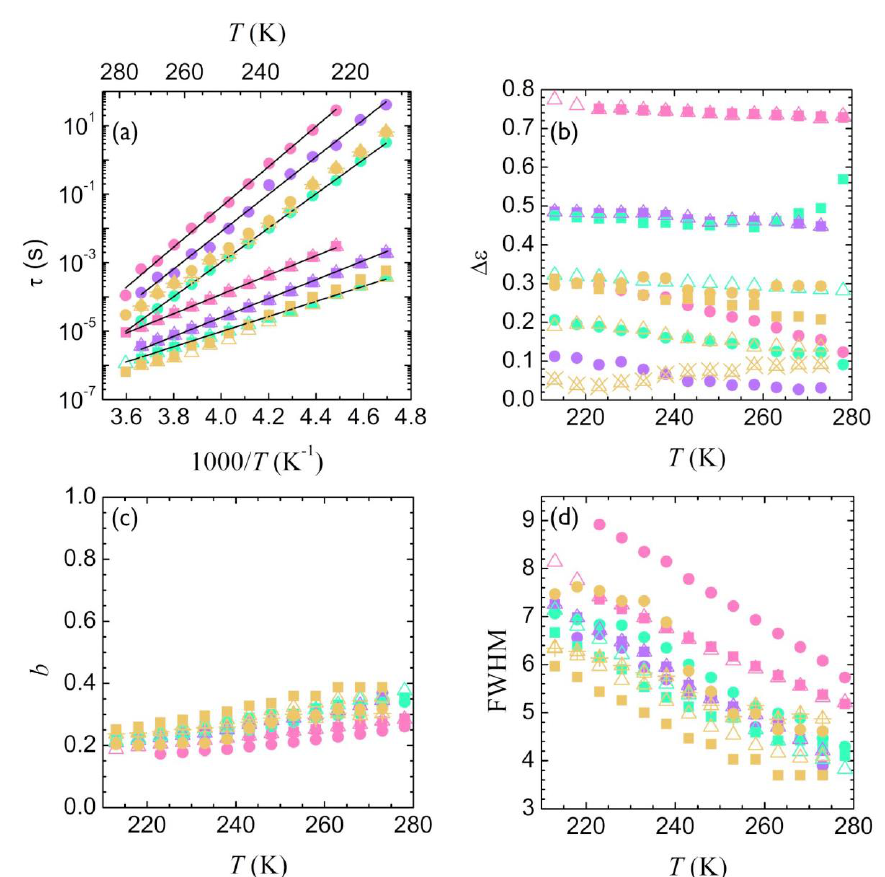
Figure 2. ( a ) Relaxation plot, ( b , c ) fitting parameters, and ( d ) full width at half maximum (FWHM) as a function of temperature for the local relaxations of poly(alkylene furanoate)s: PTF (light pink), PBF (yellow), PPeF (light purple), PHF (light green). Solid symbols correspond to the β 1 ( ■ ) and β 2 (●) contributions of FC samples, while empty symbols ( Δ ) correspond to the β 1 contribution in SL samples. In the specific case of SL PBF, the contribution of β 2 is shown by crossed triangles. The results for FC PBF were taken from Ref [28].